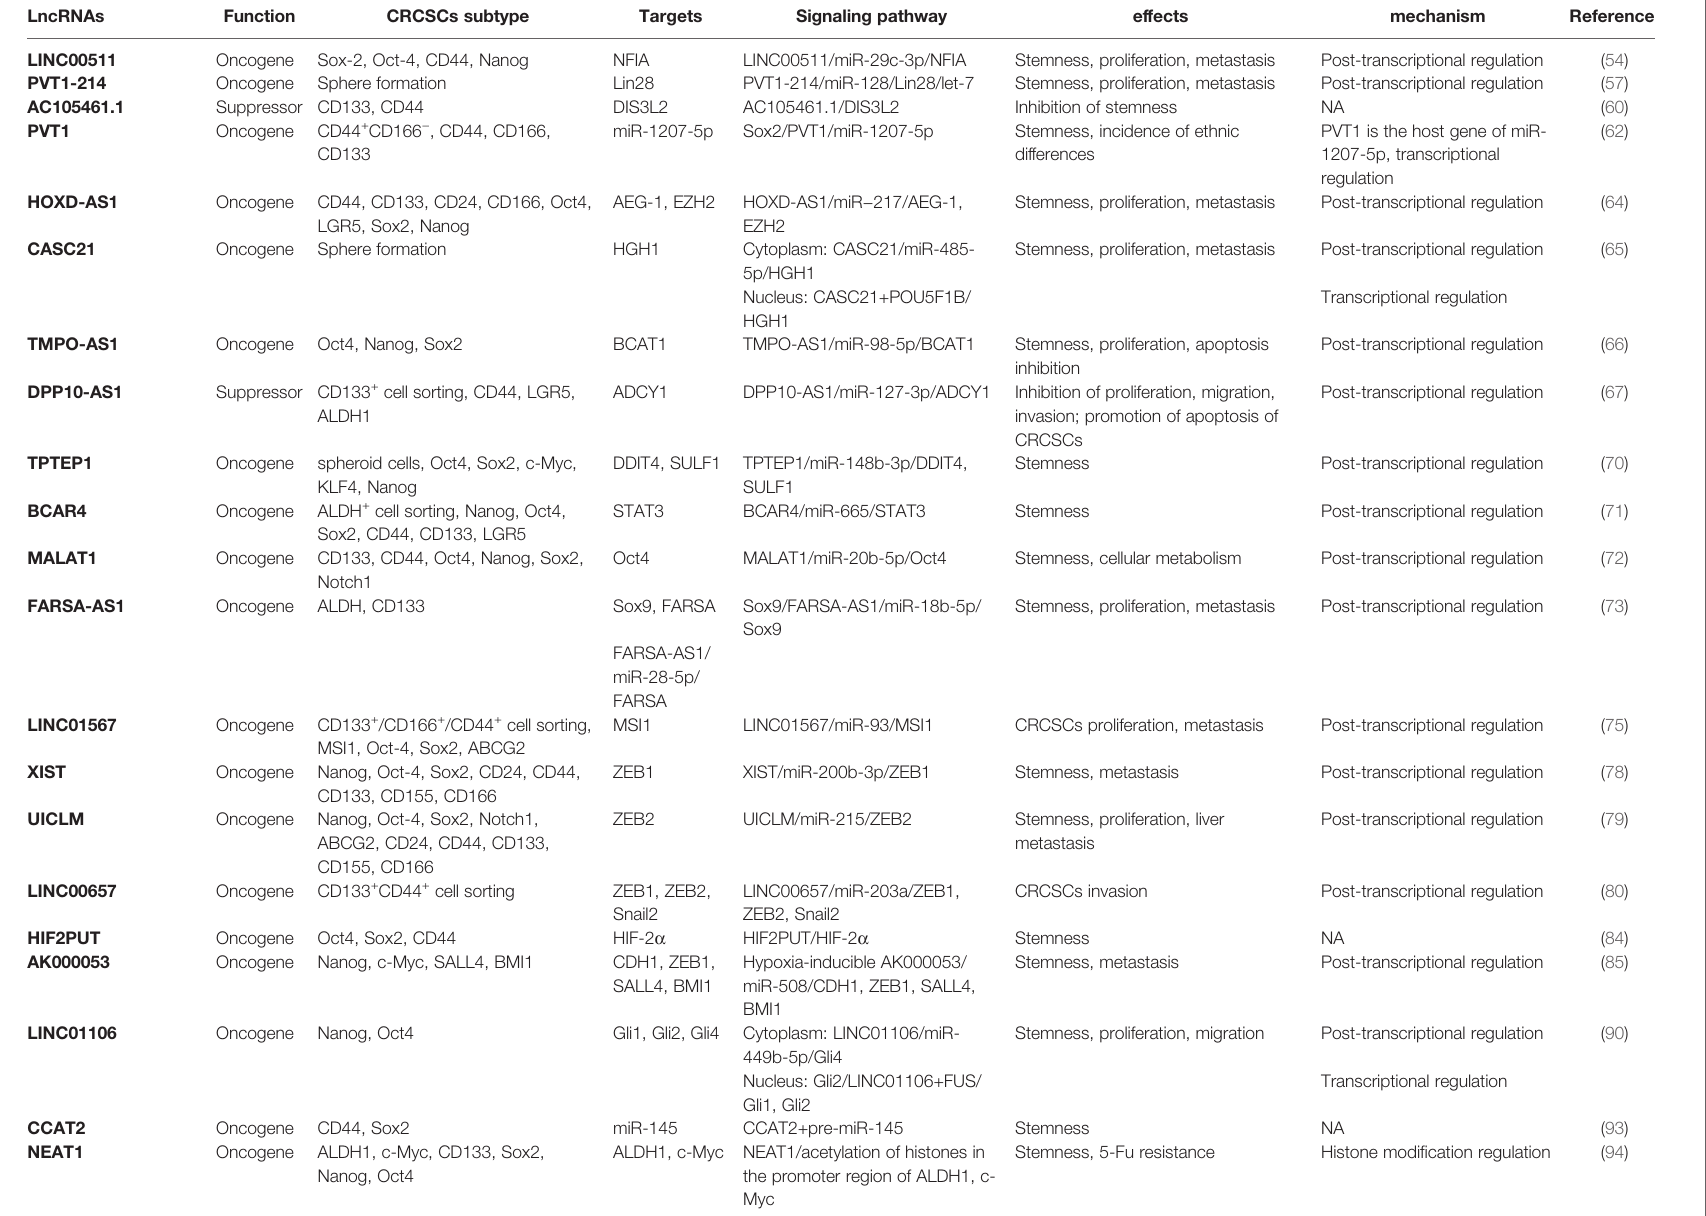
TABLE 1 | LncRNAs functioning in